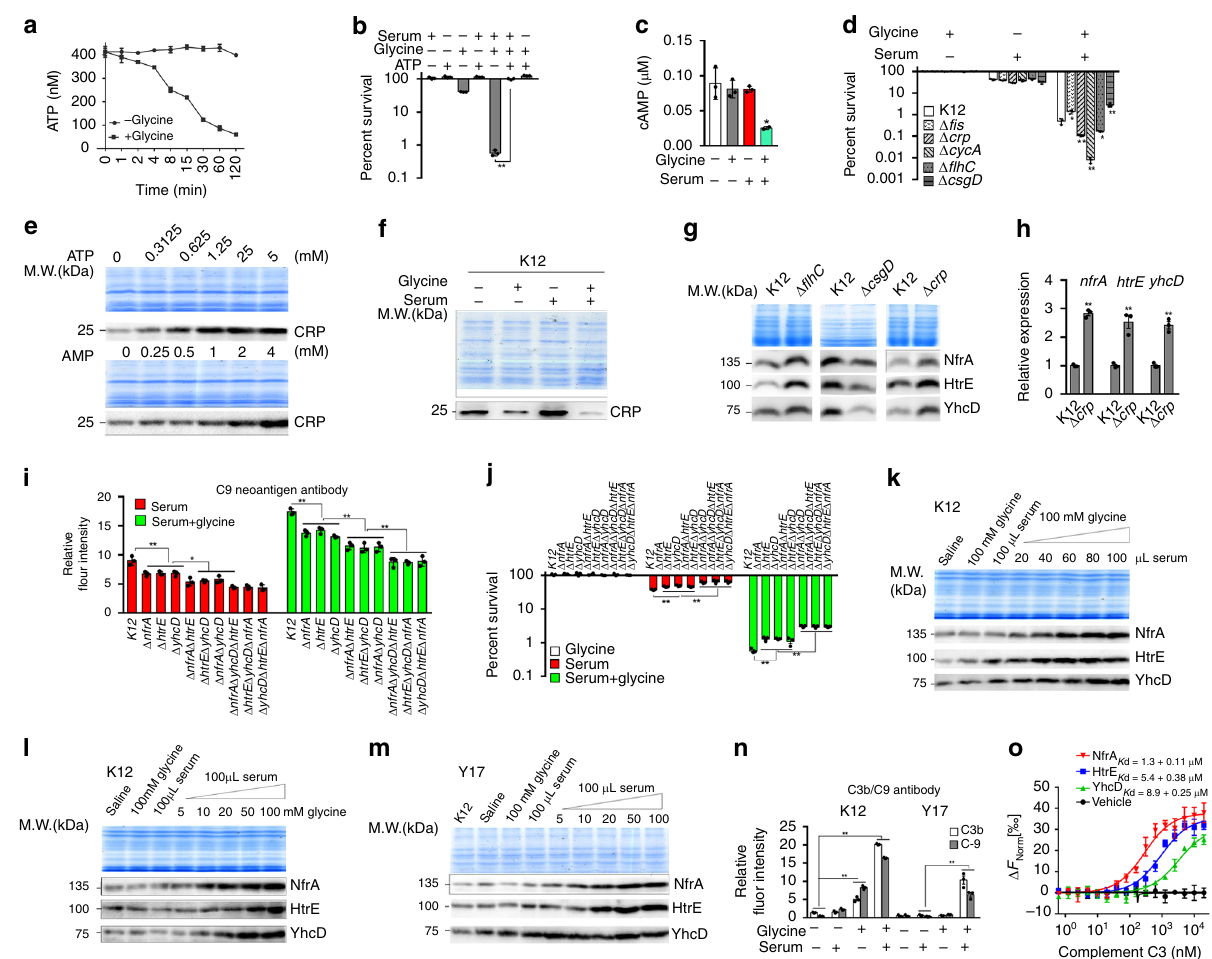
Fig. 7 Glycine-dependent mechanism for HtrE, NfrA, YhcD expression. a Relative ATP abundance of E. coli K12 in the presence or absence of 100mM glycine for the indicated length of time ( n = 3). b Percent survival of E. coli K12 in the presence or absence of 5mM ATP, 100 mM glycine or/and 100 µ L serum ( n = 3). c Relative cAMP abundance of E. coli K12 in the presence or absence of 100 mM glycine or/and 100 µ L serum ( n = 3). d Percent survival of the indicated mutants in the presence of 100mM glycine, 100 µ L serum or both ( n = 3). e Western blot of CRP in E. coli K12 exposed to 0 – 5 mM ATP or 0 – 4 mM AMP. f Effect of 100mM glycine, 100 µ L serum or both on CRP expression. g Western blot of HtrE, NfrA, YhcD in these mutants. h qRT-PCR of htrE , nfrA , yhcD in these mutants ( n = 3). i Flow cytometry quanti fi cation of anti-C9 neoantigen on outer membrane surface of the indicated mutants ( n = 3). j Percent survival of the indicated mutants in the presence of 100mM glycine, 100 µ L serum or both ( n = 3). k Western blot of HtrE, NfrA, YhcD of E. coli K12 in the presence of 100 mM glycine and the indicated amount of serum. l , m Western blot of HtrE, NfrA, YhcD of E. coli K12 ( l ) and Y17 ( m ) in the presence of 100 µ L serum and the indicated concentrations of glycine. n Flow cytometry quanti fi cation of anti-C3b and anti-C9 neoantigen on E. coli K12 and Y17 in the presence or absence of 100 µ L serum or 100 mM glycine or both. o , MST for the interaction of complement C3 with HtrE, NfrA, YhcD ( n = 3). i , n 50,000 cells were record with forwarding versus side scatter and were gated before data acquisition. Results in ( a – d , h – j , n , o ) are displayed as mean± SEM, and signi fi cant differences are identi fi ed (* p < 0.05, ** p < 0.01) as determined by two-tailed Student ’ s t test. See also Supplementary Figs. 10 –